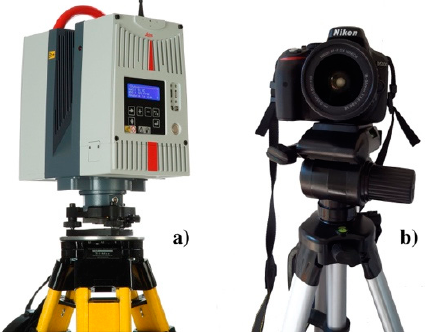
Figure 5. ( a ) The Leica HDS-6200 TLS; ( b ) The Nikon D5300 digital reflex camera.